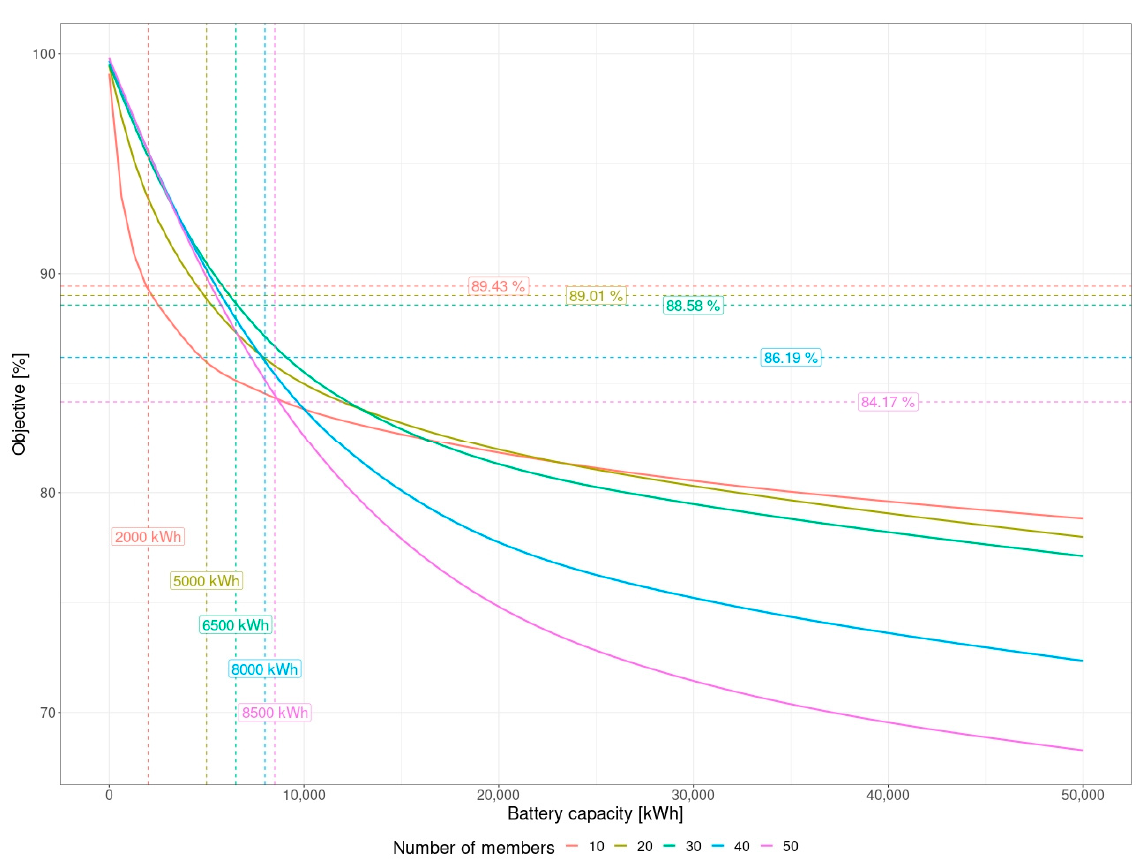
Figure 3. Simulation results of the optimization effect of the sum of energy taken from the network and energy remaining in the network deposit after the billing period, depending on the battery capacity and the number of cooperative members. Also seen is the average effect and battery capacity per average effect.